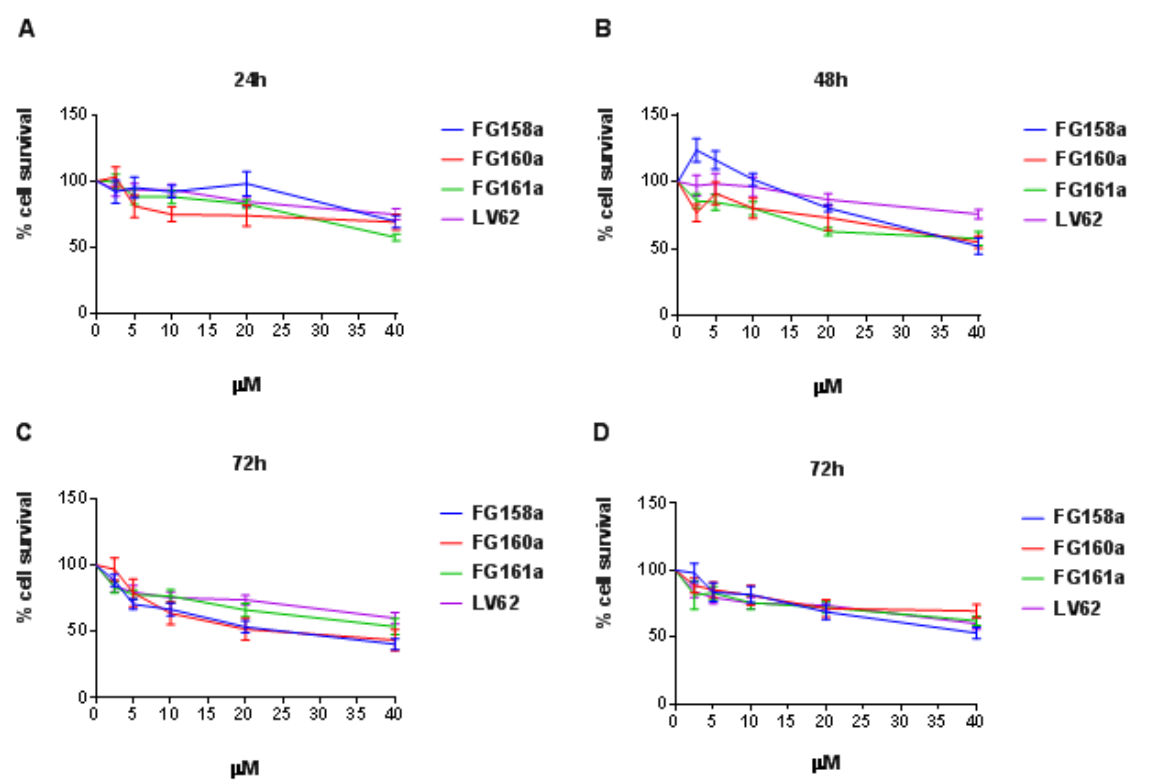
Figure 4. Inhibition of cell viability. The effect on cell viability by CB2R agonists was determined by sulforhodamine B (SRB) assays in SH-SY5Y and SK-N-BE cell lines. SH-SY5Y cells were treated with the compounds indicated in the figure for 24 h ( A ), 48 h ( B ), and 72 h ( C ) at the concentrations reported in the histograms. SK-N-BE cells were treated with the same compounds for 72 h ( D ). Figures report cell viability (mean of at least 3 independent experiments ± SEM) as percent of cell survival vs. untreated cells (considered as 100% of survival). In SH-SY5Y cells after 72 h of treatment, the IC 50 values were: FG158a = 11.8 µ M; FG160a = 13.2 µ M, FG161a = 27.53 µ M, LV62 = 38.11 µ M. The statistical significance was calculated with two-way ANOVA using Dunnett’s multiple comparisons